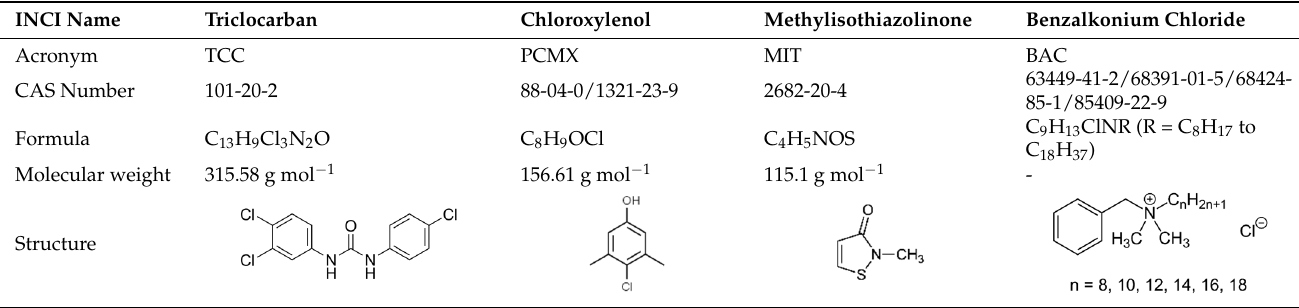
Table 1. Basic information on the target preservatives.